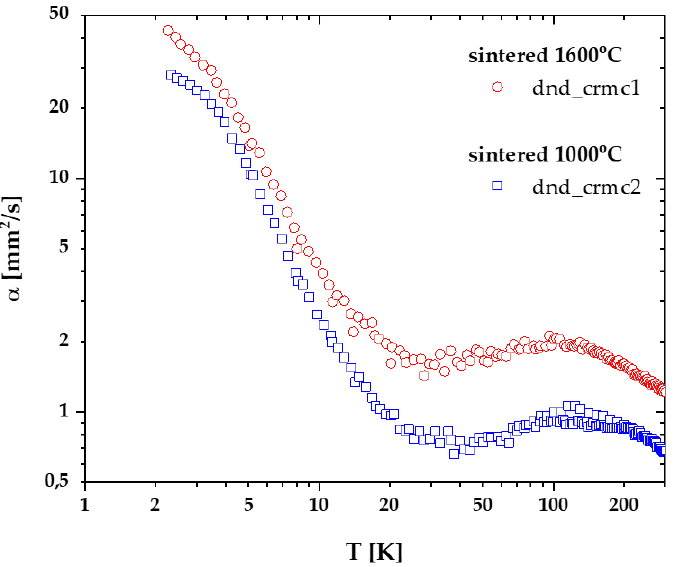
Figure 8. Thermal diffusivity of detonated nanodiamond ceramics sintered in different tempera- tures.